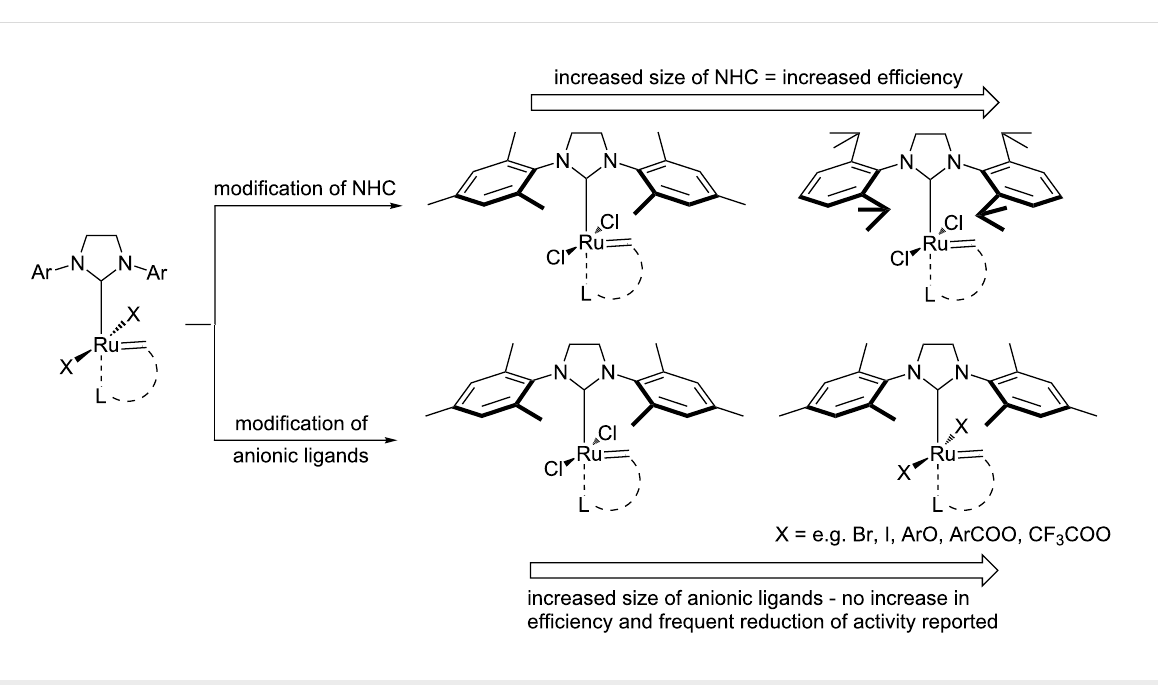
Scheme 1: Modifications of the 2 nd generation alkylidene